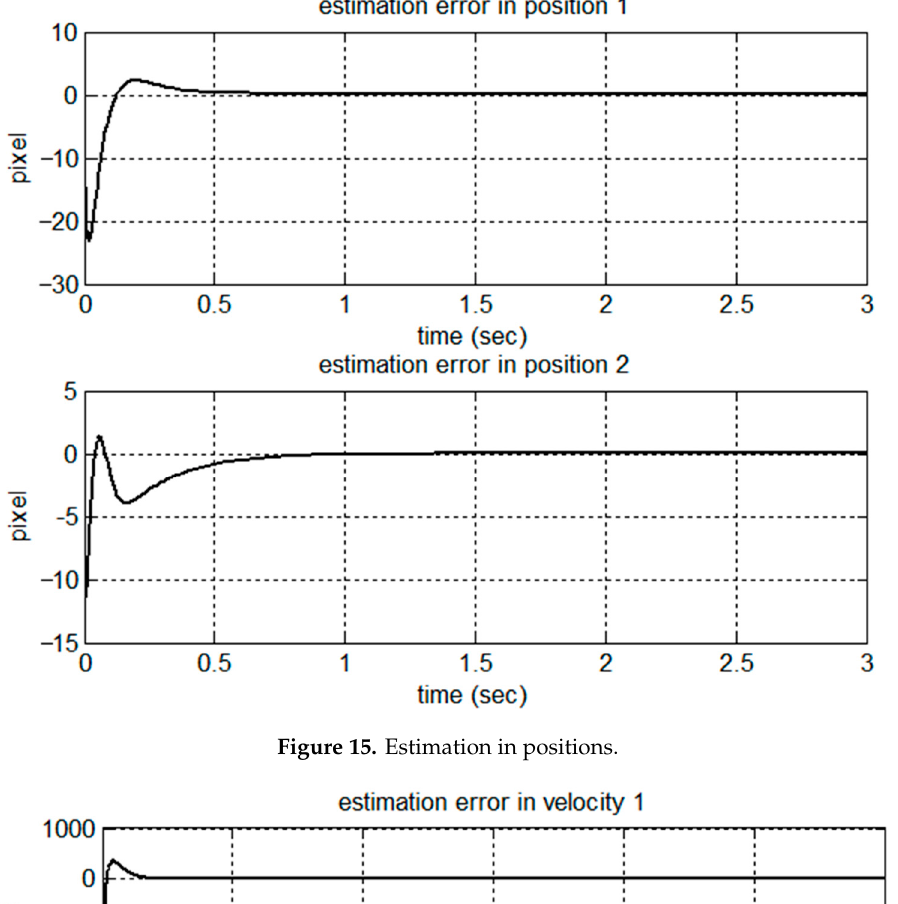
Figure 14. Estimation of kinematic parameters.